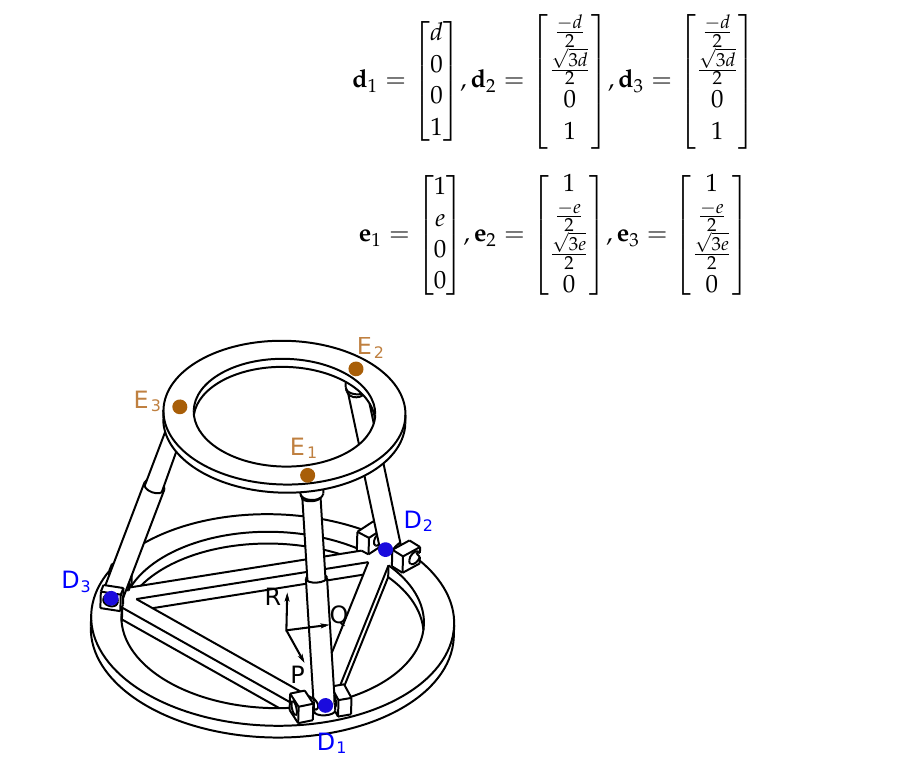
Figure 4. 3-RPS parallel